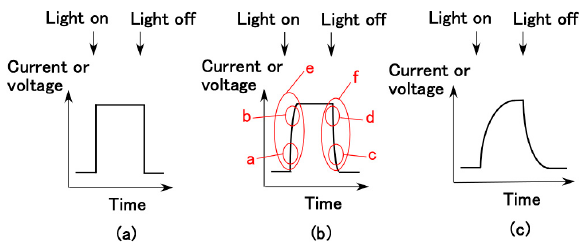
Figure 7. Schematic response curve of voltage and electric current by light-on and off: ( a ) no time lag; ( b ) dominant with t 1 or t 3 ; ( c ) dominant with t 2 .